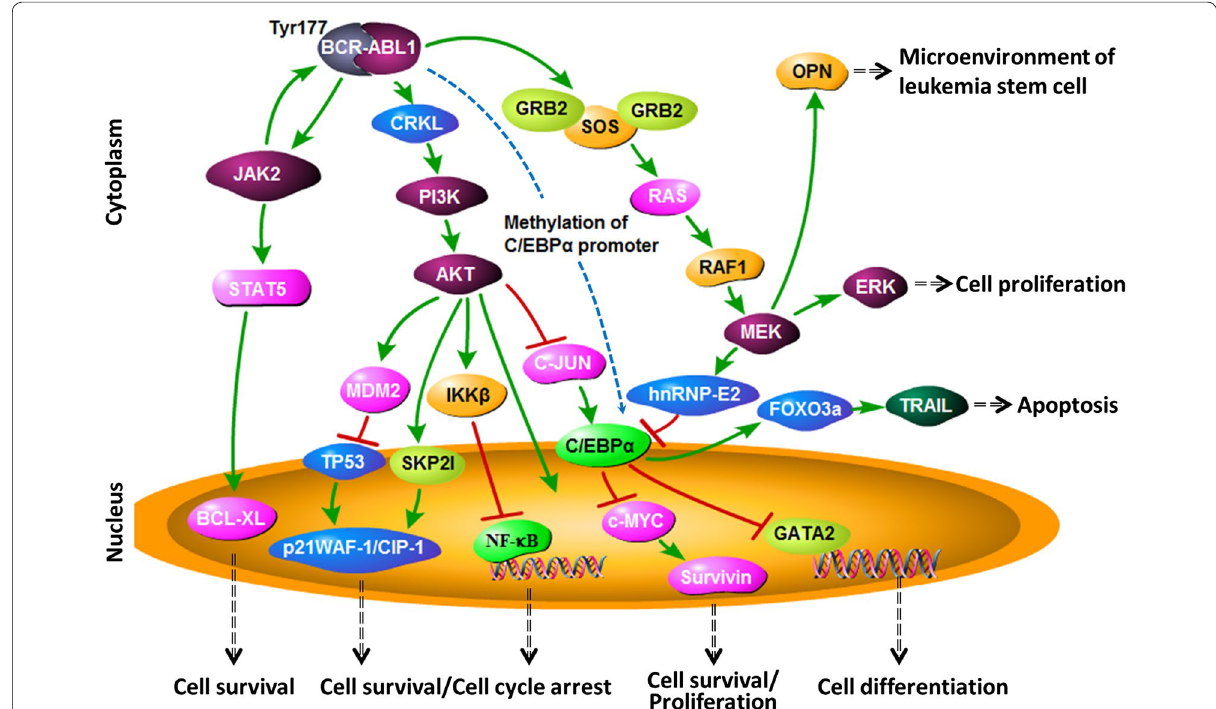
Fig. 2 Main pathways regulated by the BCR‑ABL1 protein. The downstream pathways regulated by BCR‑ABL1 protein associated with cell survival, cell proliferation, cell cycle, cell differentiation, apoptosis, and the microenvironment of leukemia stem cells. Dark violet shapes indicate the kinase; lavender pink shapes indicate the proven oncoprotein; blue shapes indicate the proven tumor suppressor protein; and other color shapes indicate the proteins existing in normal cells. Red solid lines indicate inhibiting; green solid lines indicate activating. Blue dotted lines indicate that the results need further confirmation. Black dotted lines indicate the functions associated with the signaling pathway. JAK2 janus kinase 2, STAT5 signal transducers and activators of transcription 5, BCR ‑ XL B‑cell lymphoma‑extra‑large, CRKL Crk‑like protein, PI3 K phosphatidylinositol 3‑kinase, AKT protein kinase B,